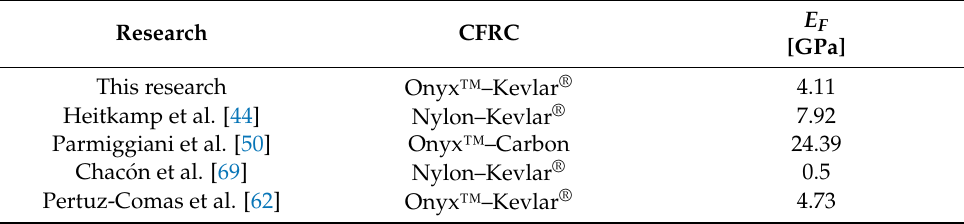
Table 6. Flexural modulus comparison with other CFRC